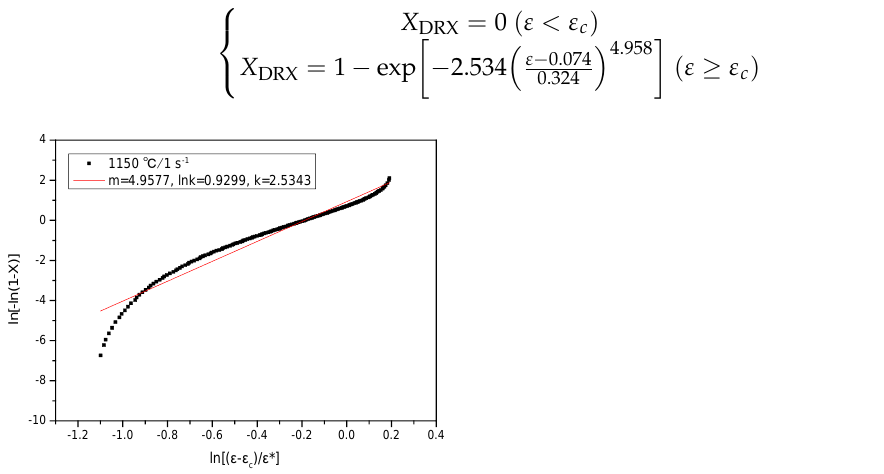
(cid:105) (cid:104) ( ε − ε (𝜀−𝜀 𝑐 ) c ) ] at 1150 °C and 1 s −1 . at 1150 ◦ C and 1 s − 1 . ε ∗ 𝜀 ∗